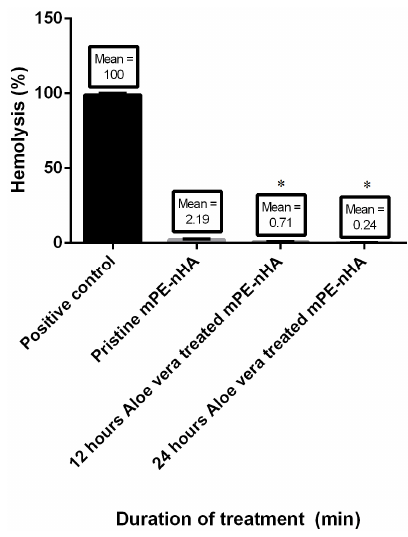
Figure 10. Comparison of the hemolysis percentage of the positive control, pristine mPE ‐ nHA, 12 h and 24 h Aloe vera dip ‐ coated mPE ‐ nHA ( n = 3). Values shown are mean ± SD and * indicates that differences in the mean are significant ( p < 0.05) with respect to the mPE control.